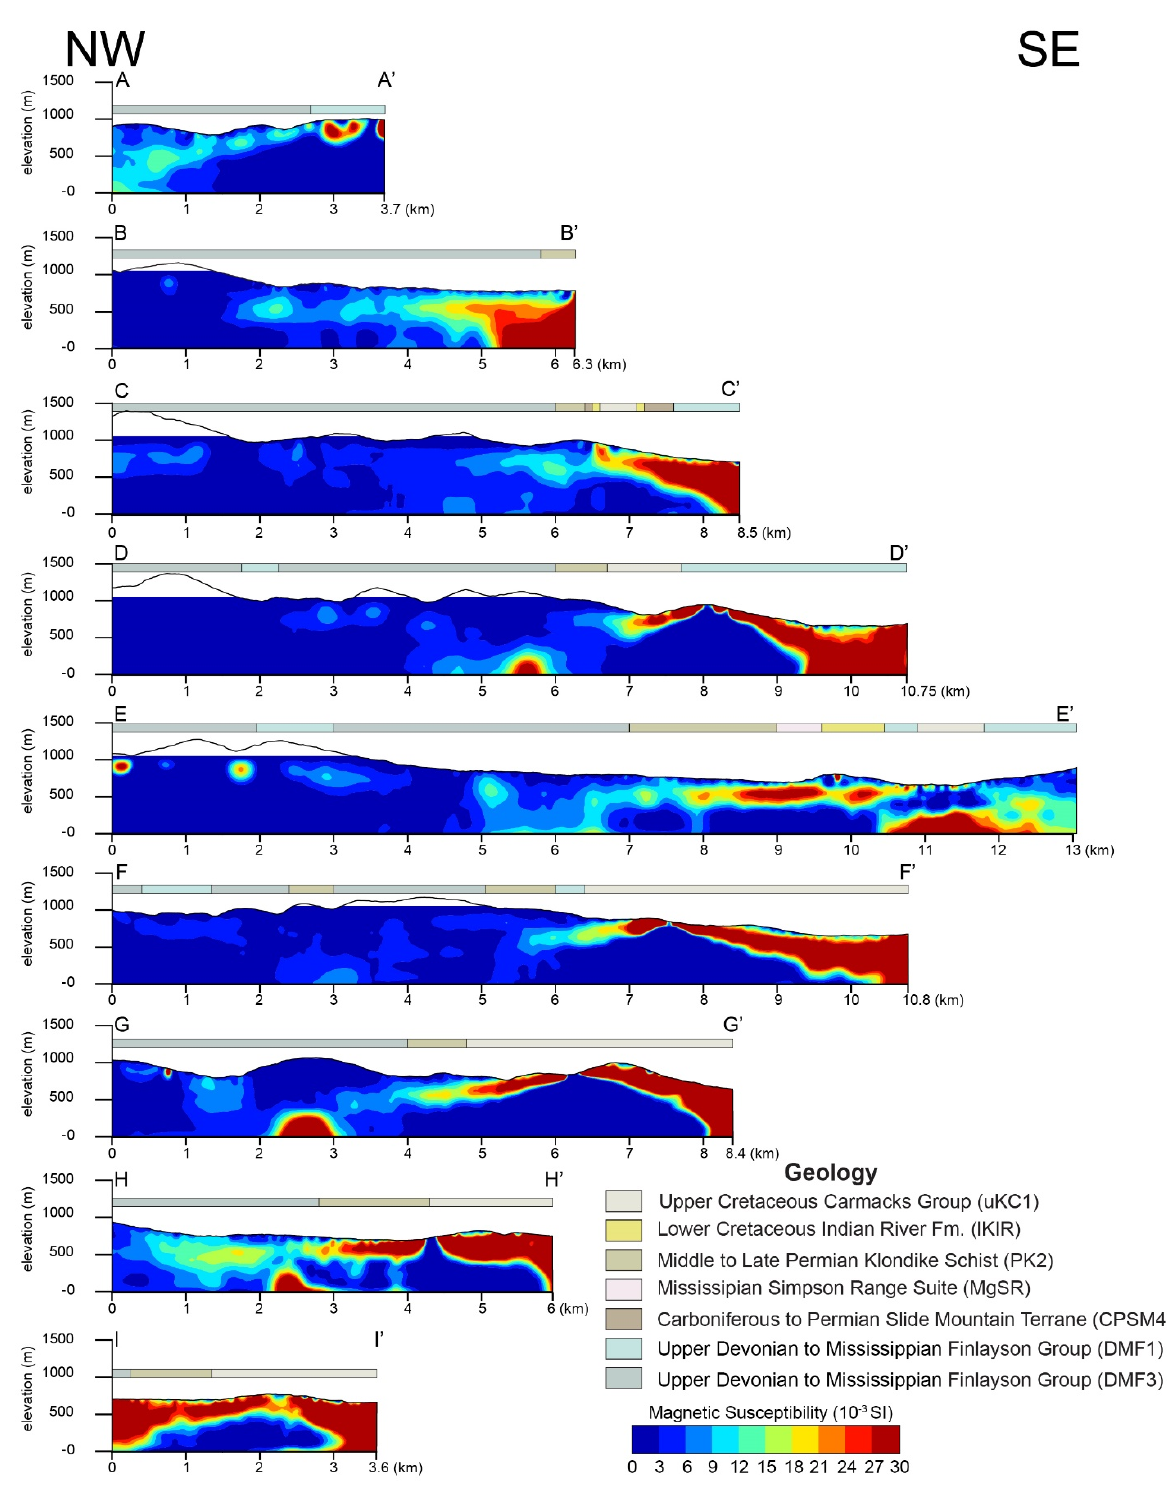
Figure 14. Cross-sections through the 3D magnetic susceptibility data juxtaposed to plots of the corresponding geologic units at surface. corresponding geologic units at